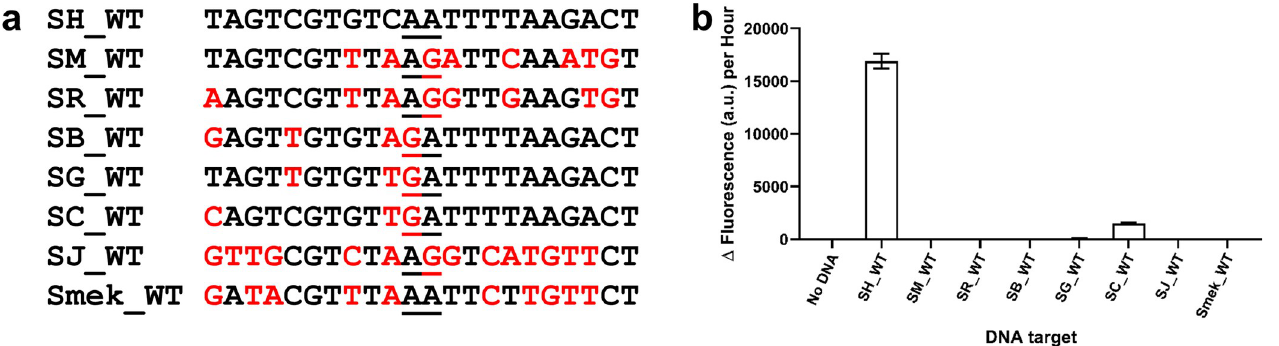
Fig 3. S . haematobium probe set specificity. a , DNA targets tested against S . haematobium probes. SH_WT is the target region that probes SH_A1 and SH_B1 are designed to recognise. The corresponding target region for the other related Schistosoma species are indicated as follows: SM_WT ( S . mansoni ), SR_WT ( S . rodhaini ), SB_WT ( S . bovis ), SG_WT ( S . guineensis ), SC_WT ( S . curassoni ), SJ_WT ( S . japonicum ) and Smek_WT ( S . mekongi ) with sequence variations indicated in red. The ligation junction for the probes is underlined. b , S . haematobium probes are specific for the S . haematobium wild-type target region. Both half probes and the target concentrations were tested at 50 nM. n = 9 (3 replicates per reaction, each reaction split into triplicate runs). Error bars denote standard error of the mean. The sequences of the probes are available in S1A Table.